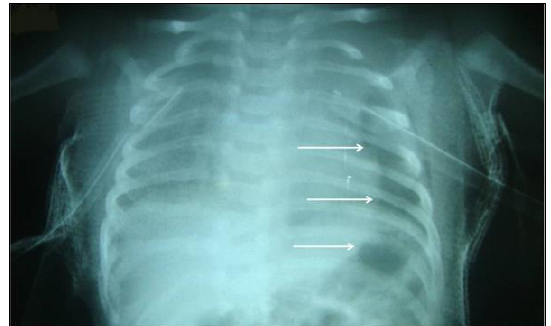
Figure 1: Chest radiograph showing a well-defined longitu- dinal gas shadow (arrows) extending from the left hypo- chondrium, across the diaphragm into the chest cavity. CT-chest showed an intact left hemidiaphragm with no diaphragmatic hernia. However, it showed subcutaneous emphysema extending from D4-D9 spine level on the left posterior thoracic wall (Fig. 2) that was mimicking a bowel gas shadow on the chest